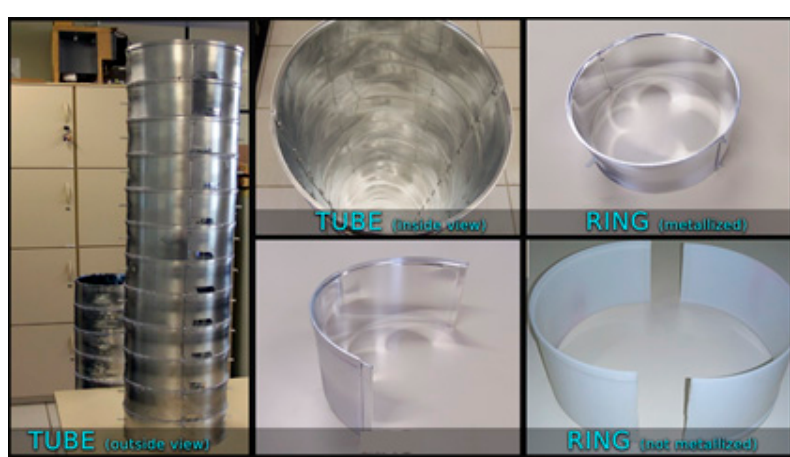
Figure 4. Dimensions of developed arcs.